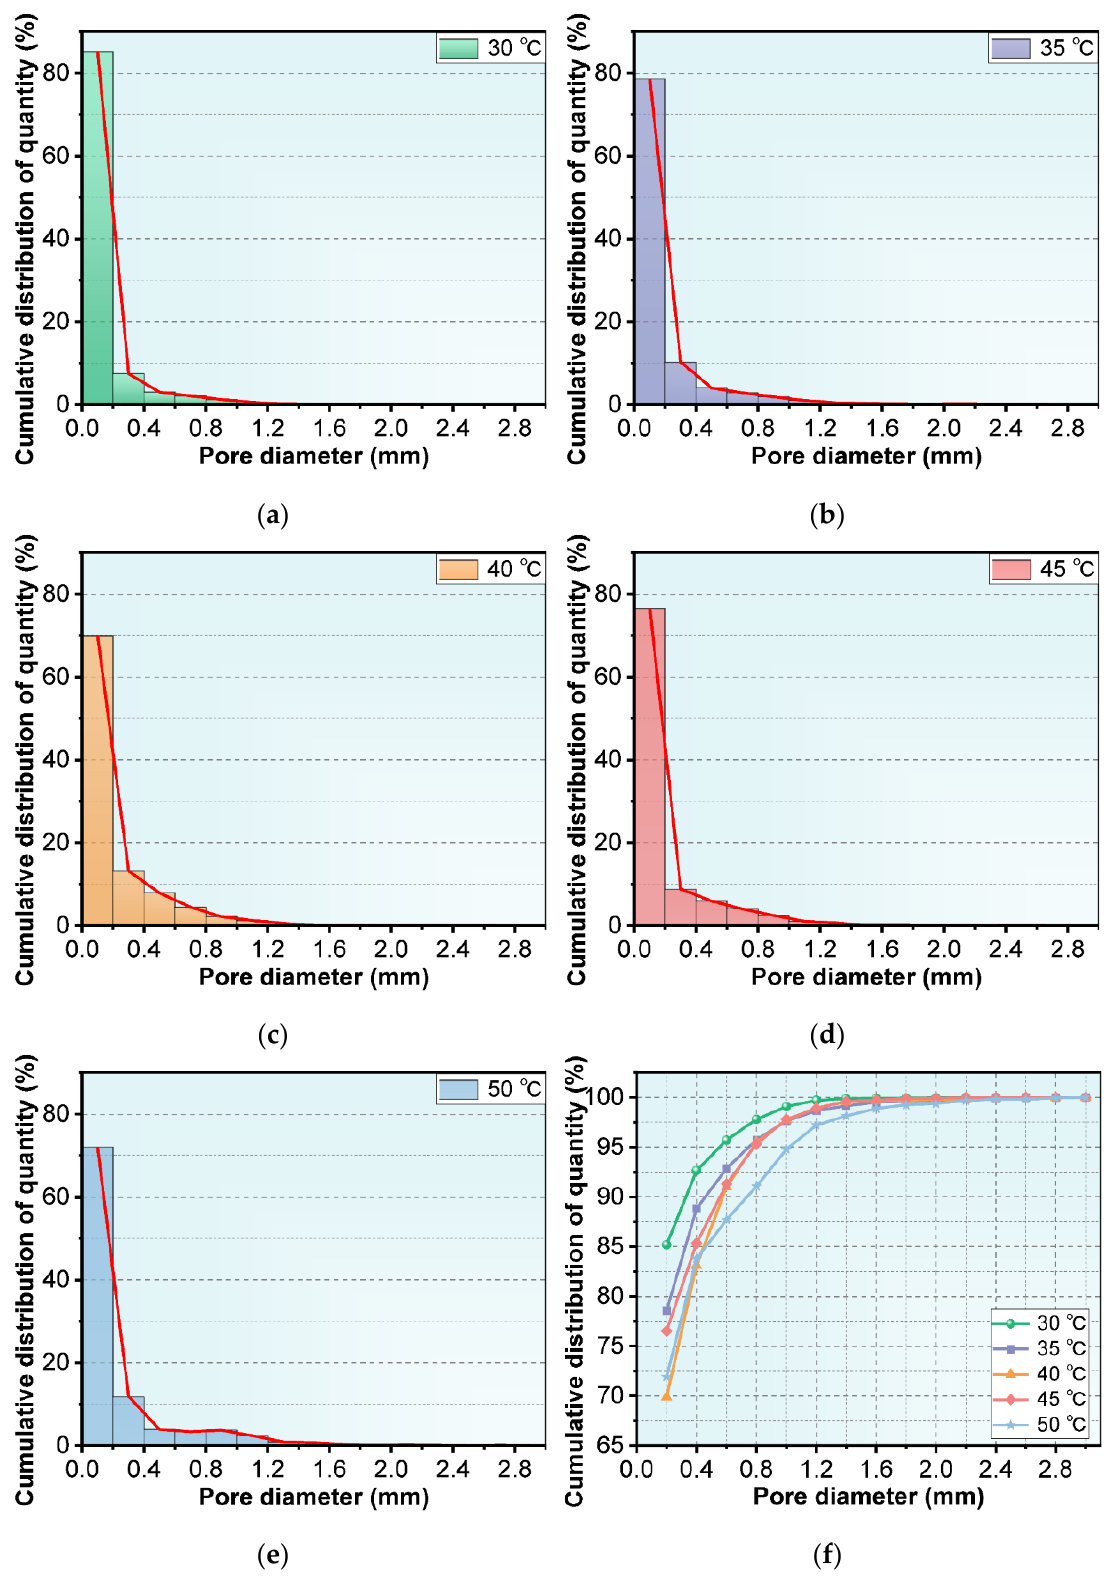
Figure 8. Pore number distribution at ( a ) 30 °C, ( b ) 35°C, ( c ) 40 °C, ( d ) 45 °C and ( e ) 50 °C; ( f ) cumulative frequency distribution of the pore number at different curing temperatures.